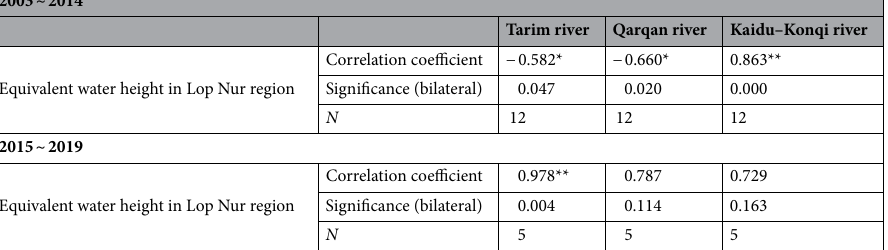
Table 6. Pearson’s correlation between equivalent water height in the Lop Nur region and the water surface area of each tributary river during two periods (2003 ~ 2014, 2015 ~ 2019). *Significance level with alpha = 0.05, **Significance level with alpha = 0.01.